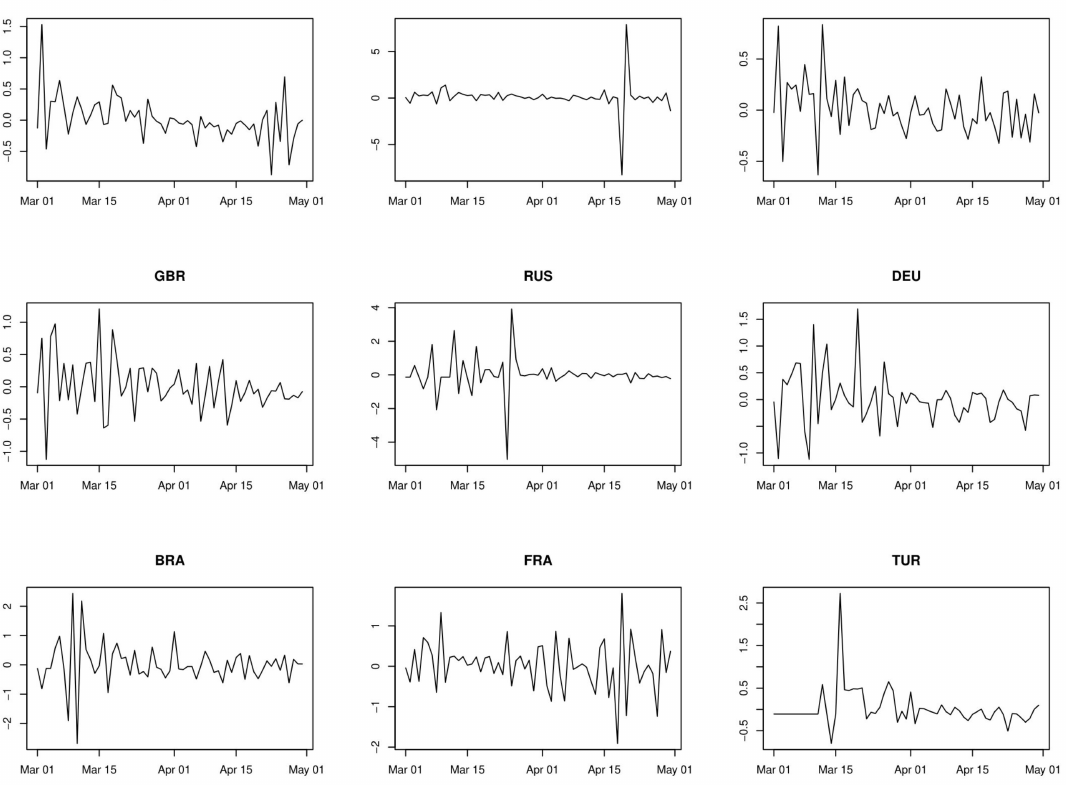
Figure 1. Growth rates of the nine countries with highest number of cases until end of April 2020: